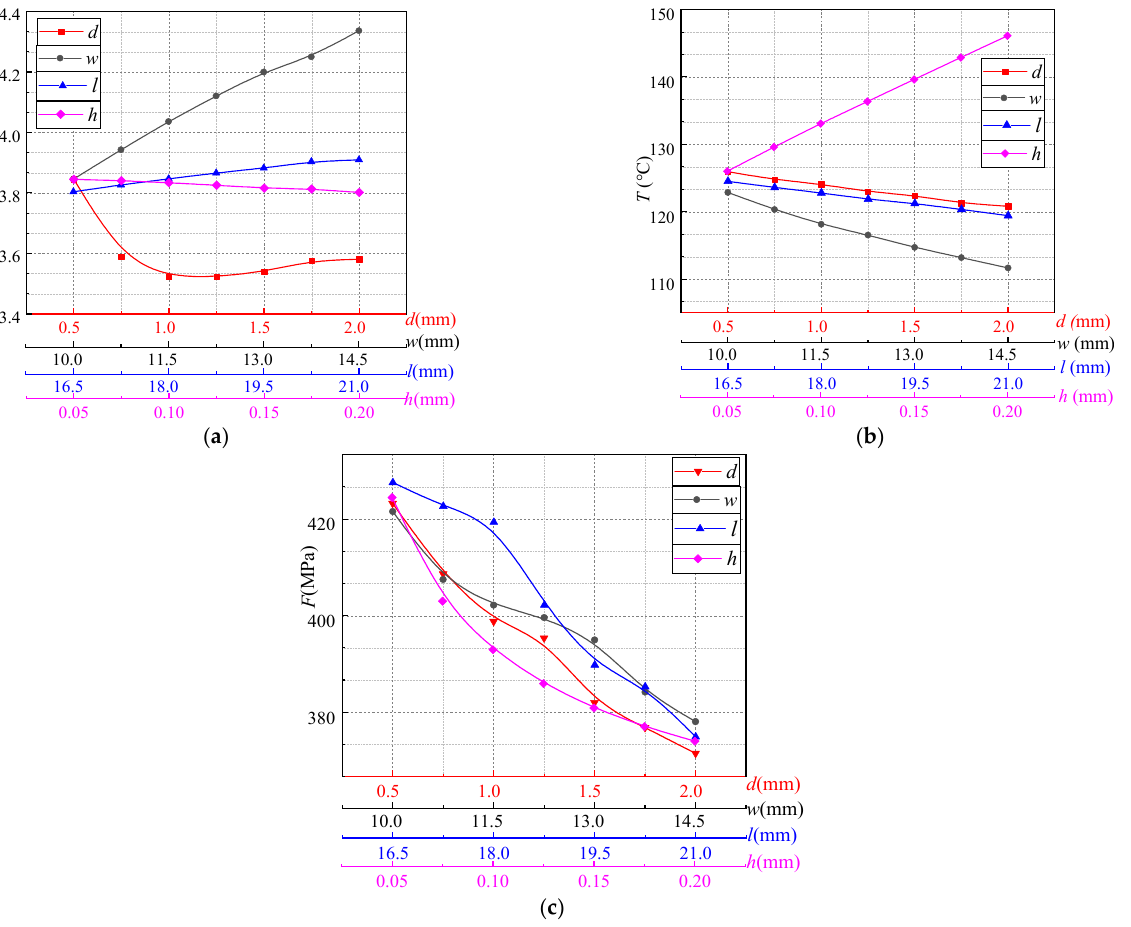
Figure 8. Effects of packaging structure parameters on the electric field, temperature, and mechanical stresses: ( a ) maximum electric field; ( b ) maximum temperature; ( c ) maximum mechanical stress.